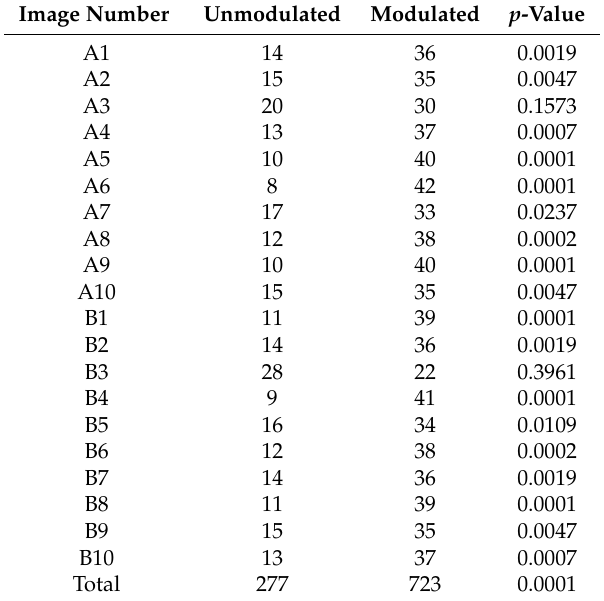
Table 1. Comparing the Zebbiche JND model and its saliency modulated JND model based on the number of votes collected from 24 subjects.The first 10 images are from Group A, and the others are from Group B.